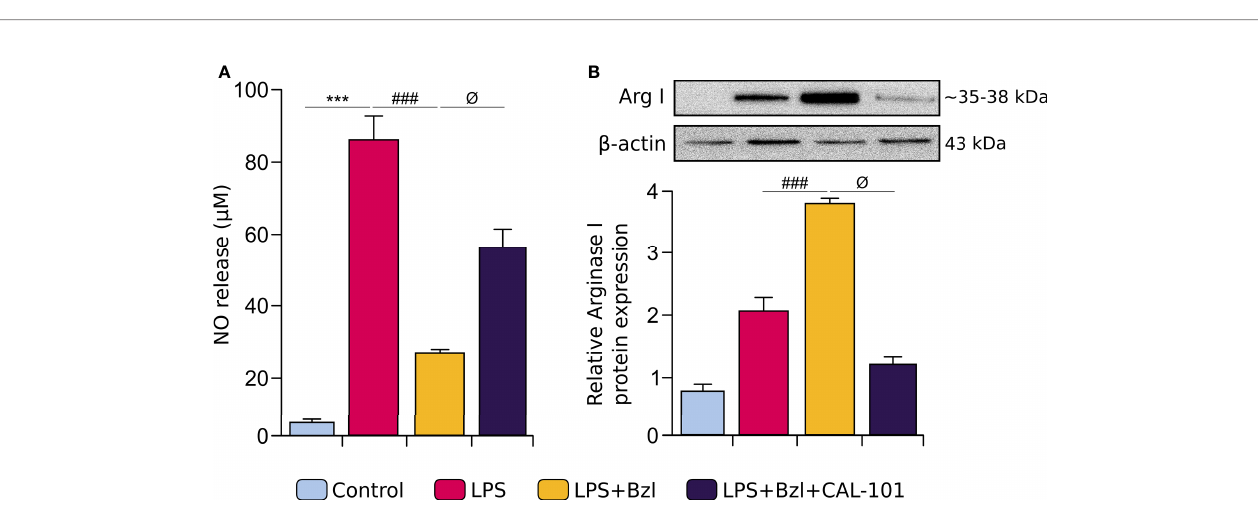
FIGURE 8 | RAW 264.7 macrophages were treated with 10 m M CAL-101, a speci fi c inhibitor of p110 d , the catalytic subunit of PI3K d isoform, 30 min before the addition of 15 m M benznidazole (Bzl). Cells were stimulated with 10 µg/mL LPS 30 min after Bzl treatment. After 48 h, NO levels were quanti fi ed by the Griess reaction in culture supernatants (A) and relative Arginase I (~35-38 kDa) protein expression was determined by Western blot with a speci fi c antibody and normalized against b -actin (43 kDa) (B) . Results are expressed as the mean of 3 independent experiments (n=3, 5 replicates/treatment) ± SEM. *** P < 0.0001 vs. control cells, ### P < 0.0001 vs LPS-stimulated cells. f P < 0.05 vs . Bzl-treated and LPS-stimulated cells.